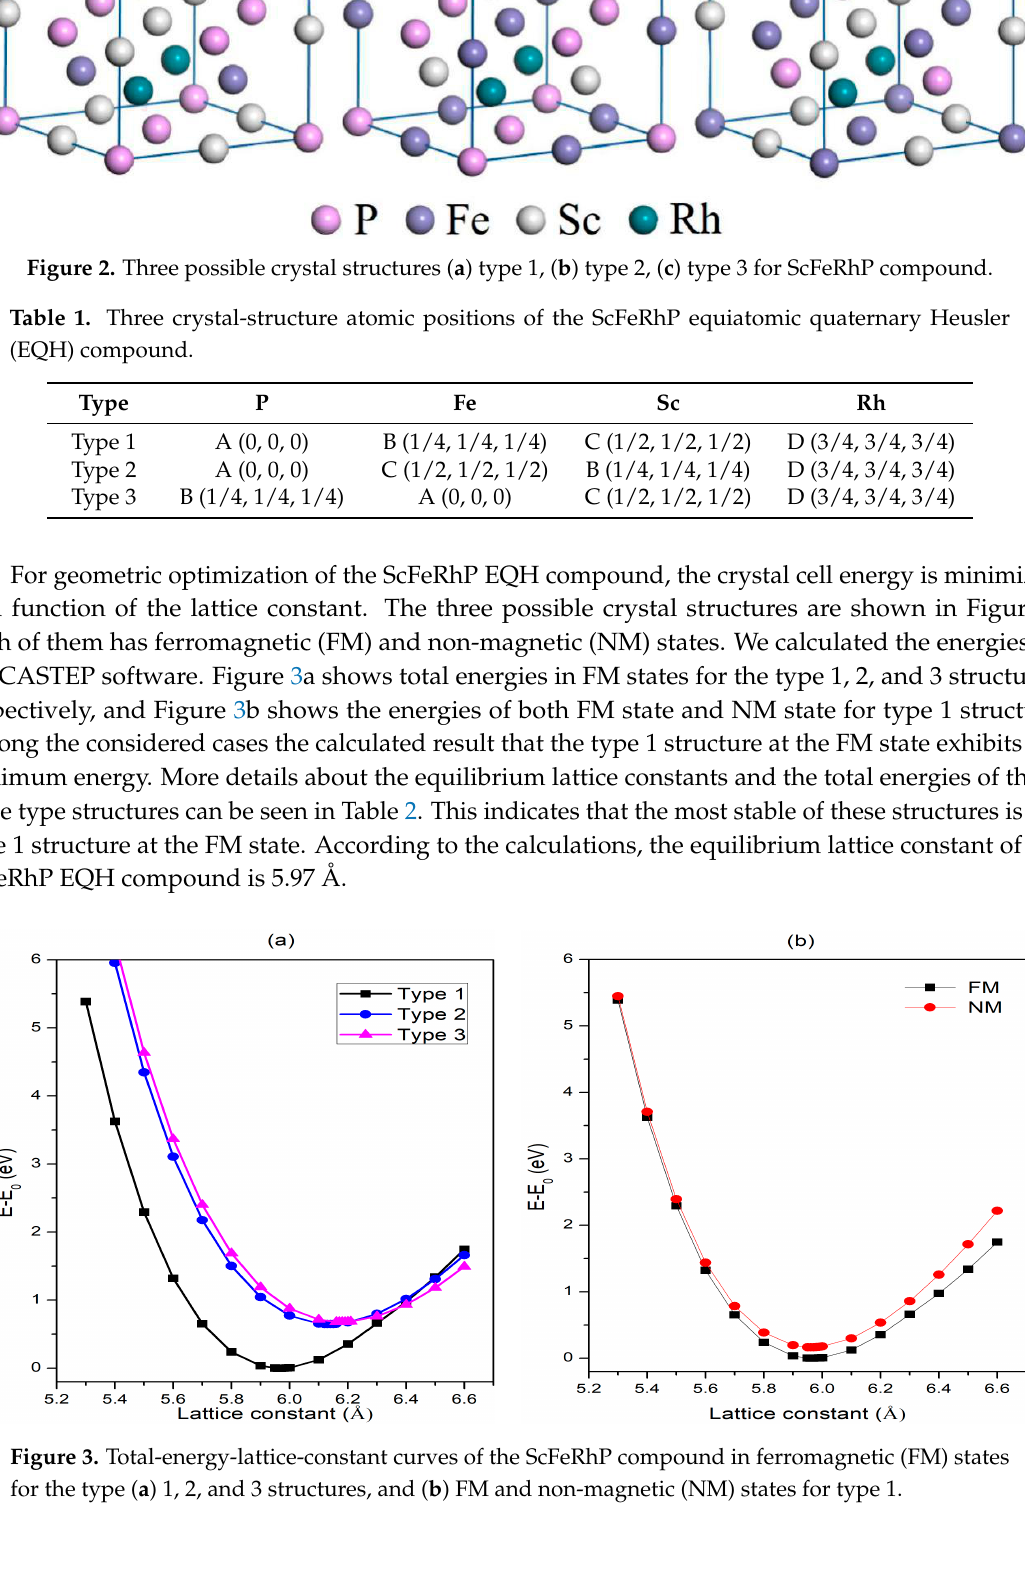
Figure 3. Total-energy-lattice-constant curves of the ScFeRhP compound in ferromagnetic (FM) states for the type ( a ) 1, 2, and 3 structures, and ( b ) FM and non-magnetic (NM) states for type 1.